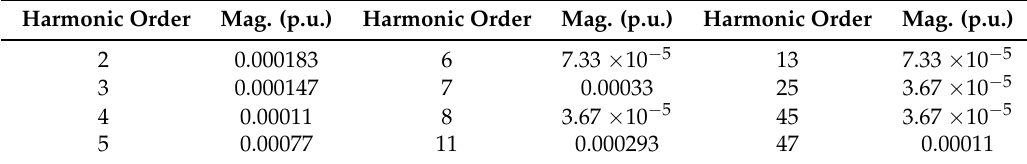
Table 2. Wind Generator Current Harmonic Content (in p.u. based on 100 MVA) [19]. Harmonic Order